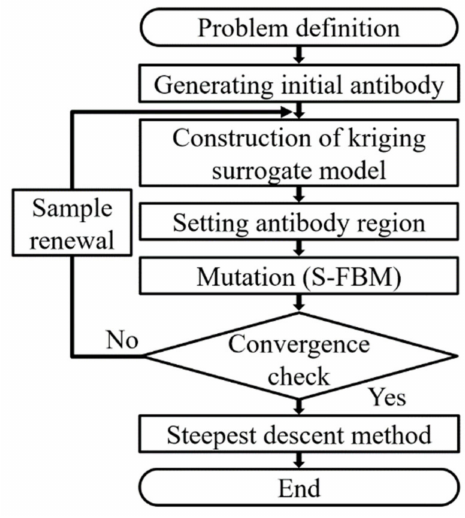
Figure 3. Flow chart of the